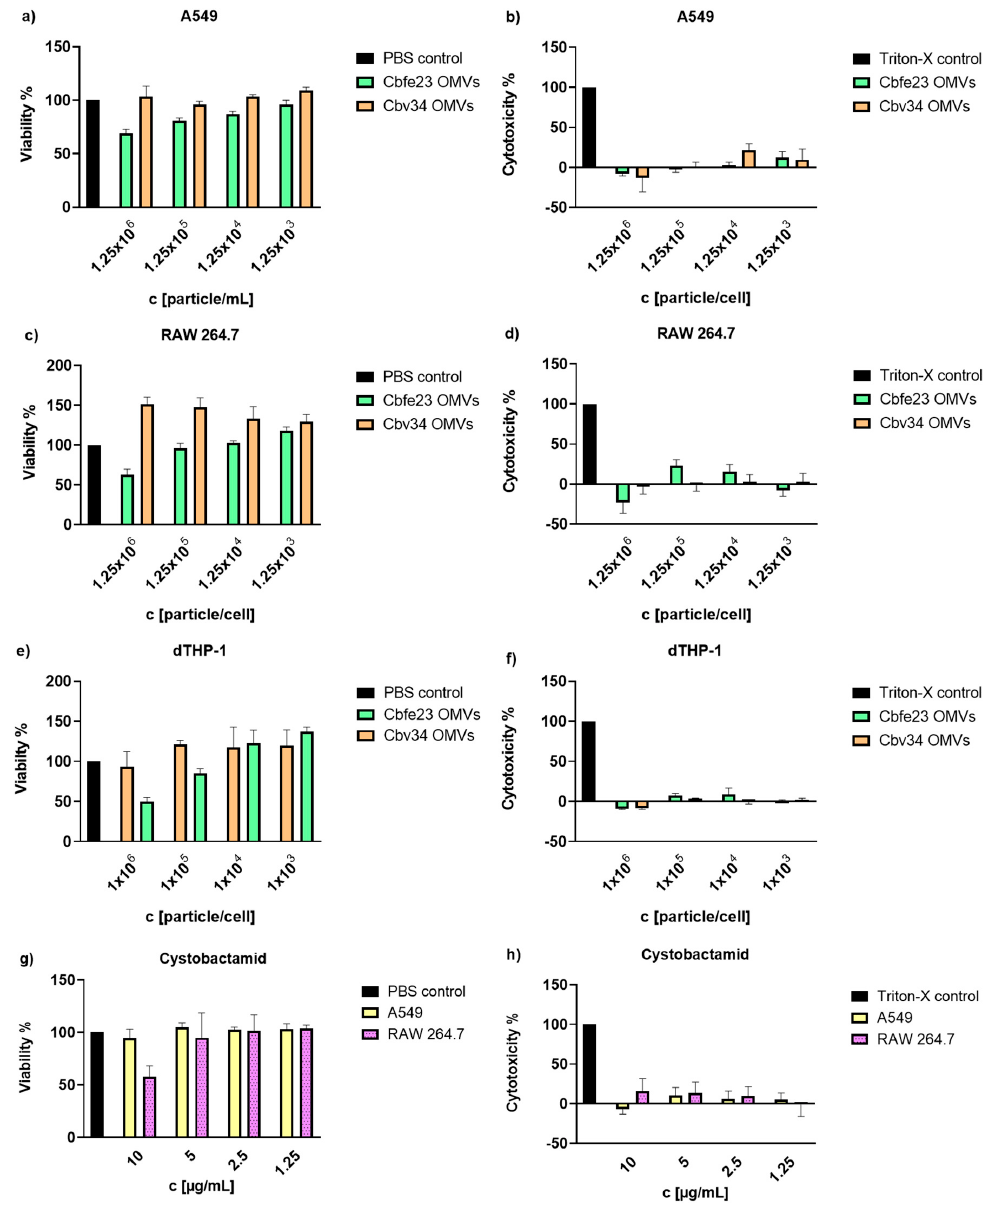
Figure 2. Cell viability and cytotoxicity of Cbv34 OMVs and Cbfe23 OMVs upon 24 h of treatment. Viability of ( a ) A549, ( c ) RAW 264.7 and ( e ) di ff erentiated THP-1 cells, and lactate-dehydrogenase cytotoxicity of OMVs incubated with ( b ) A549, ( d ) RAW 264.7 and ( f ) differentiated THP-1 cells. Effect of cystobactamid on the ( g ) viability and ( h ) cytotoxicity of A549 and RAW 264.7 cells. Mean ± SEM, n = 3. No statistically significant di ff erences were observed for any